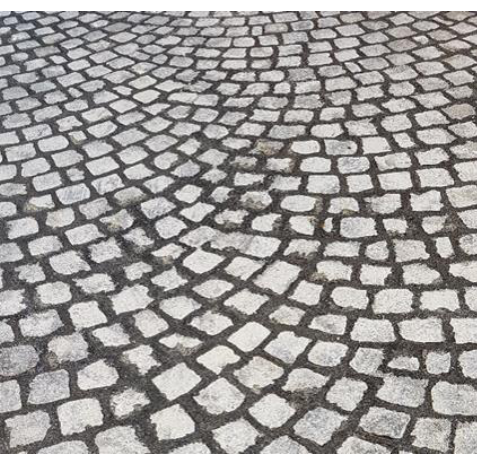
Figure 7. Fourth phase: sampietrini installation. Figure 8 summarizes all laying phases of a sampietrini pavement.